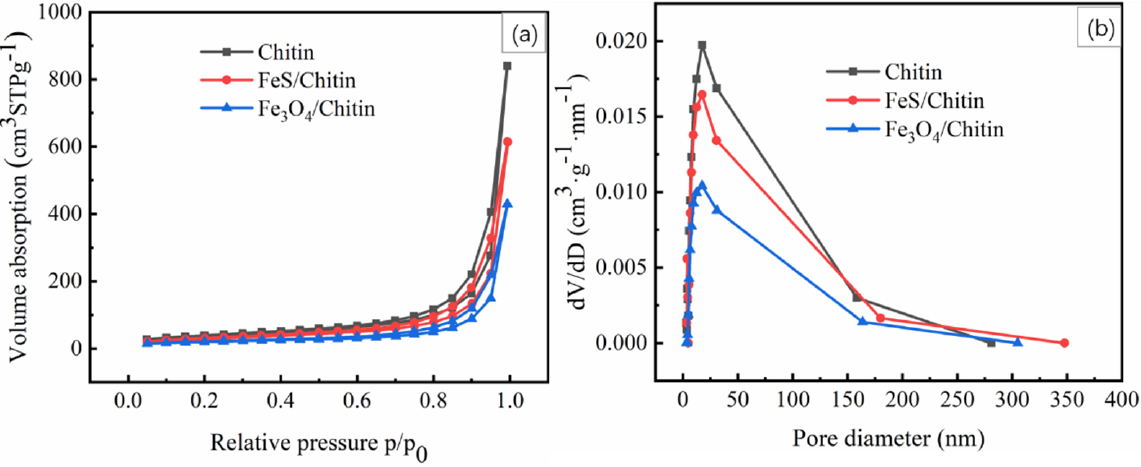
Figure 2. Nitrogen adsorption − desorption isotherms ( a ) and pore distribution ( b ) of chitin and iron-based/chitin composite membranes. Table 1. Surface properties of Chitin and Fe/Composite membrane.